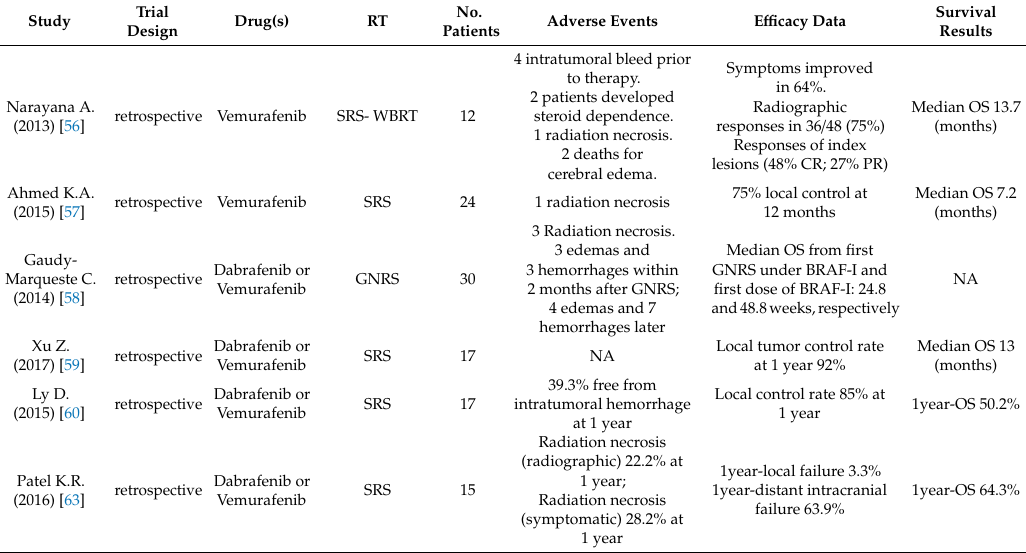
Table 2. Study of targeted therapy associated with radiation therapy in melanoma with brain metastases.